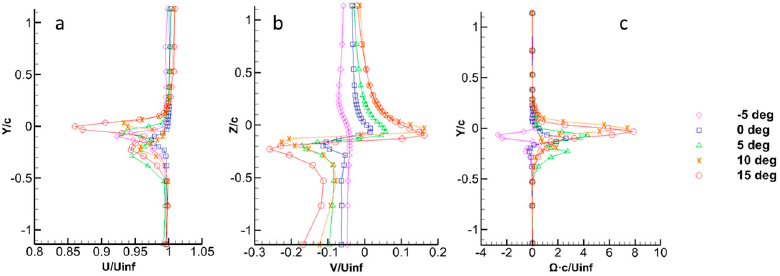
Figure 16. Time-averaged axial velocity, normal velocity, and vorticity contours at the wingtip, with winglet.